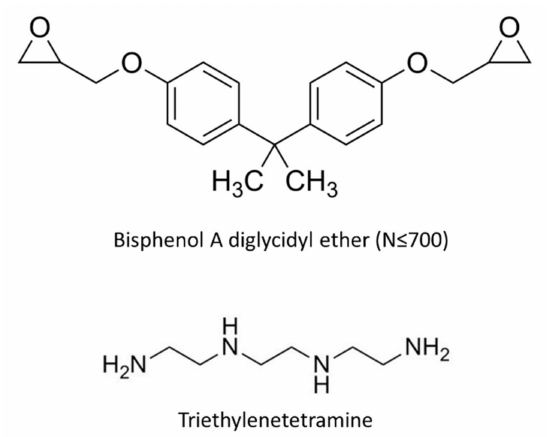
Figure 1. Materials used to synthesize shape memory